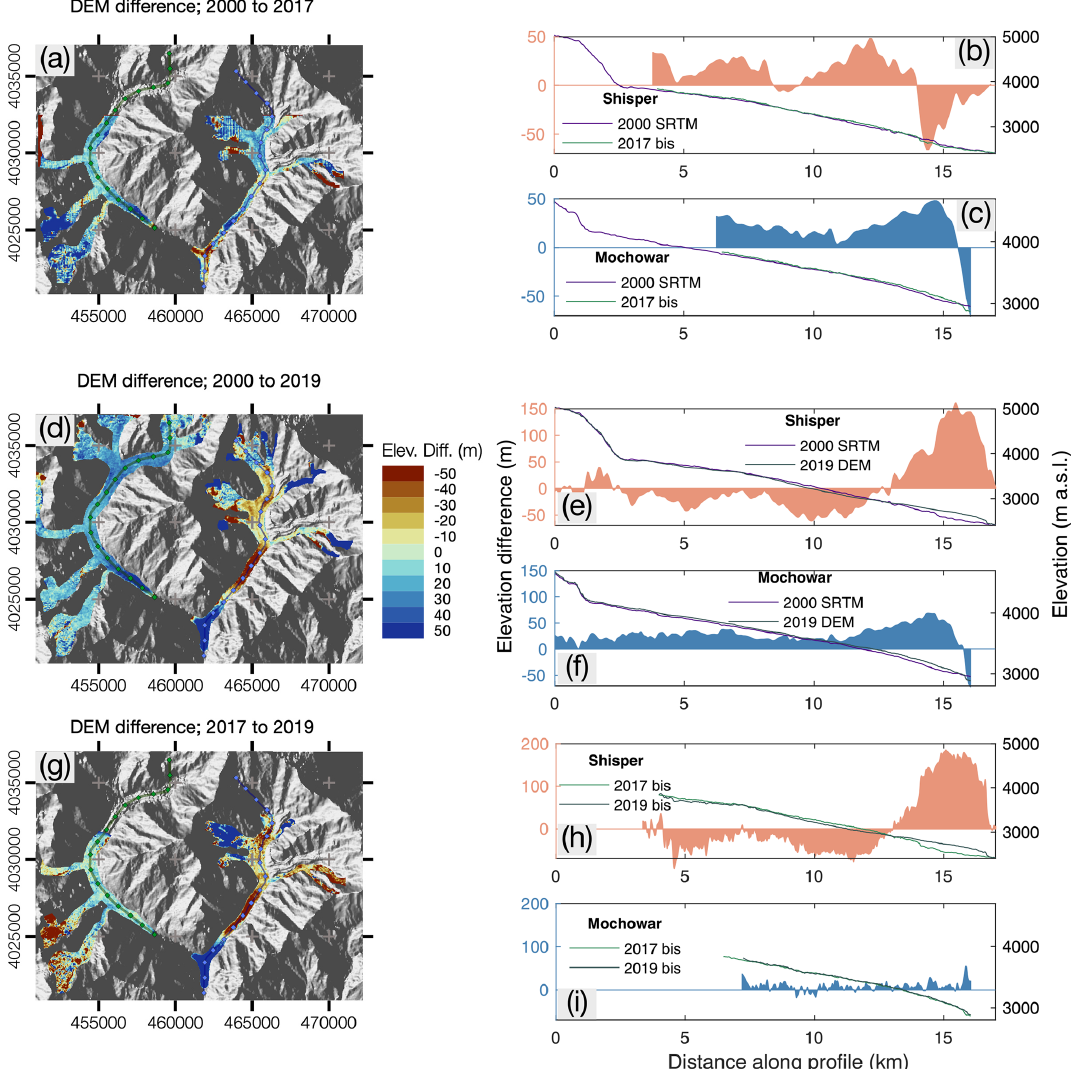
Figure 6. Surface elevation changes at the Shisper and Mochowar glaciers between 2000, 2017, and 2019. The left column represents map views of the DEM differences and the right column displays the elevation differences and surface elevations along the profiles. The elevation difference is shaded above and below 0 to highlight mass gains (above) and mass loss (below). (a) , (b) , and (c) show the difference between the SRTM DEM of 2000 and the DEM created for 2017 with PlanetScope images (2017 bis); (d) , (e) , and (f) show the difference between the SRTM DEM of 2000 and the DEM extracted from GeoEye-1 and WorldView-2 stereo-pair imagery in 2019 (2019 DEM); and (g) , (h) , and (i) show the difference between the DEM created for 2017 (2017 bis) and 2019 (2019 bis) with PlanetScope images. Note that for the PlanetScope DEMs (2017 and 2019), the available imagery did not allow the creation of DEMs covering the entirety of the glaciers, hence the data gap in the upper reaches of either glacier. The creation of the DEMs is detailed in Aati and Avouac (2020). Perceptually uniform color maps are used in this figure to prevent visual distortion of the data (Crameri, 2018a,